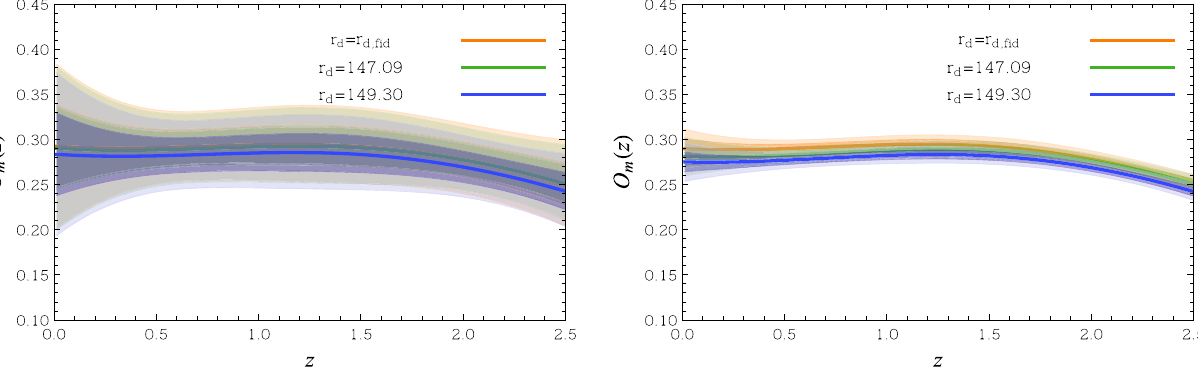
Fig. 9 O m ( z ) vs z with 1 σ and 2 σ CL regions for different values of r d (in units of Mpc), reconstructed from SN+BAO+CC data (left panel) and SN+BAO+CC+H0LiCOW data (right